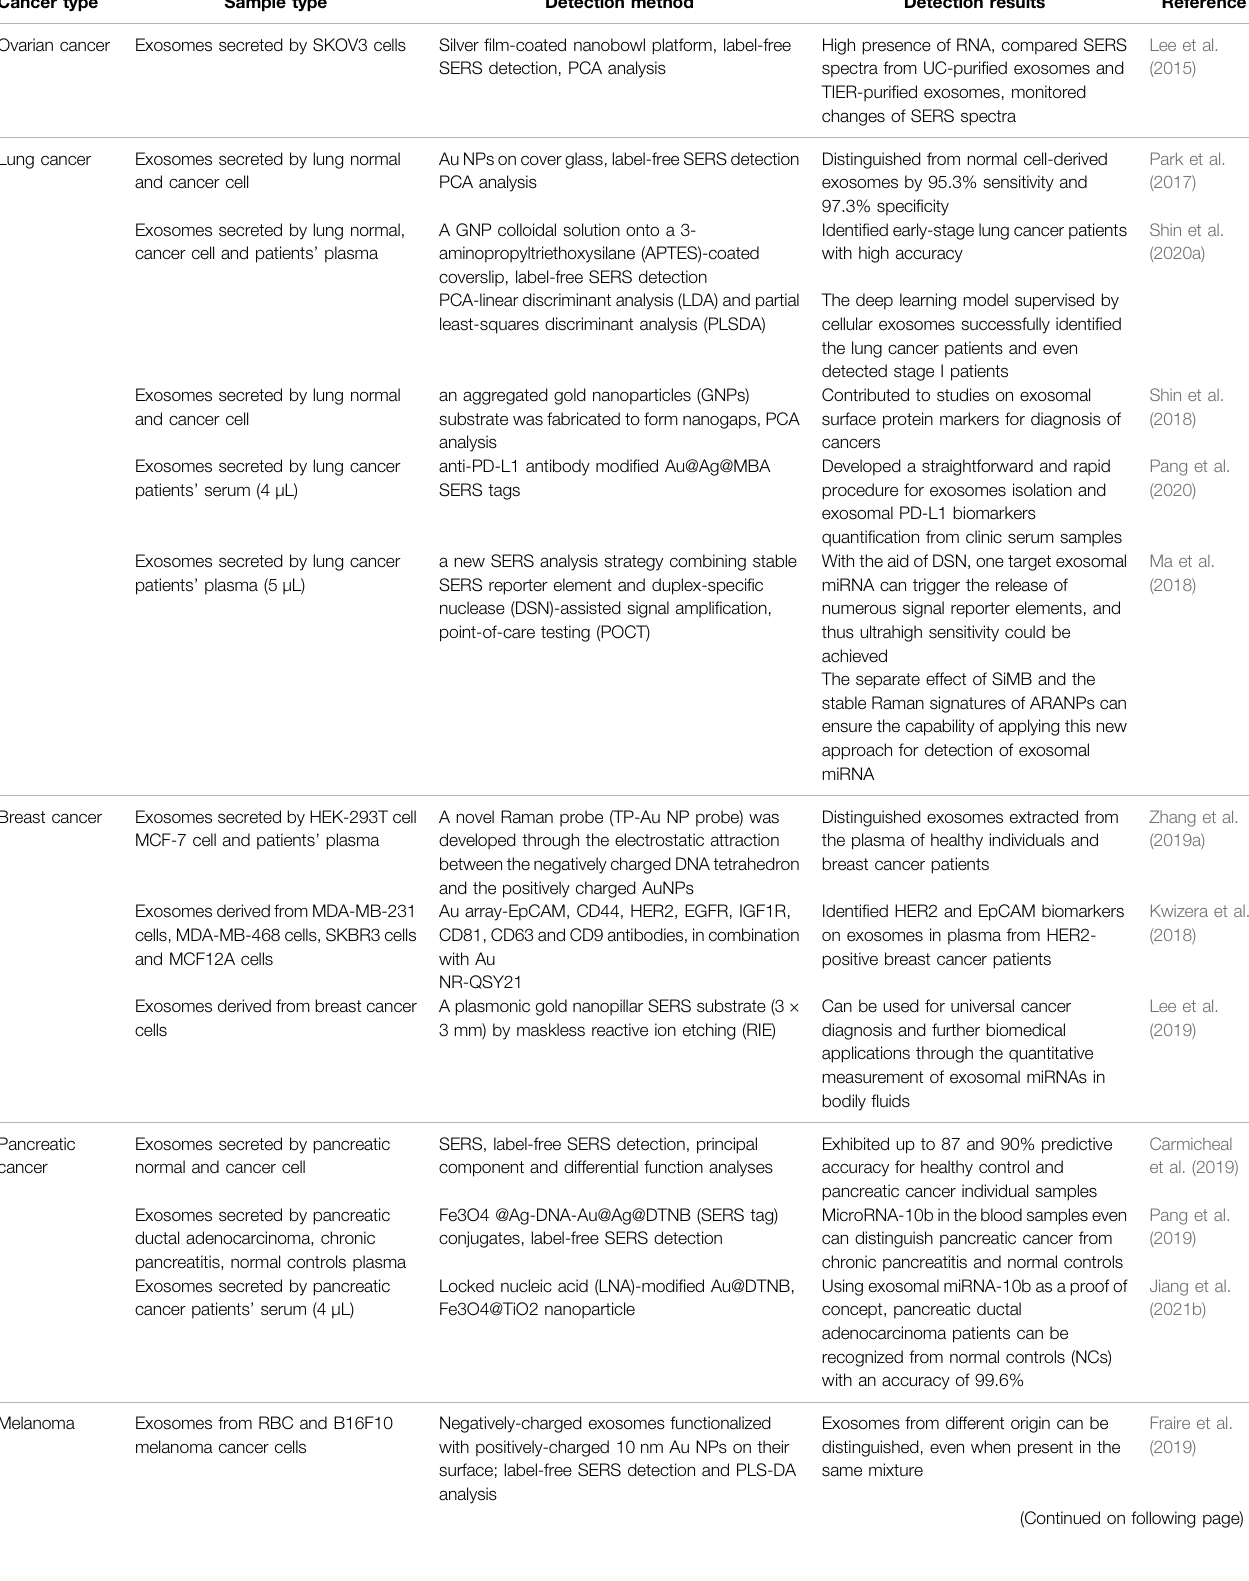
TABLE 2 | Cancer-derived exosomal biomarkers detected by SERS-based